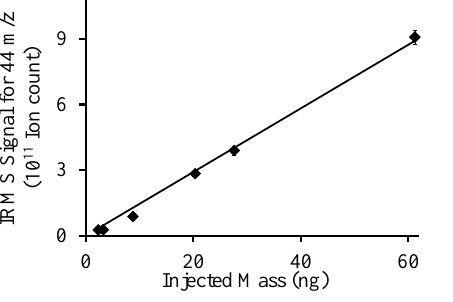
Figure 2. Calibration curve for toluene (based on TSPS-GC-IRMS measurements, slope = 1.46 × 10 10 ± 0 . 03 × 10 10 ionsng − 1 , R 2 = 0 . 997)